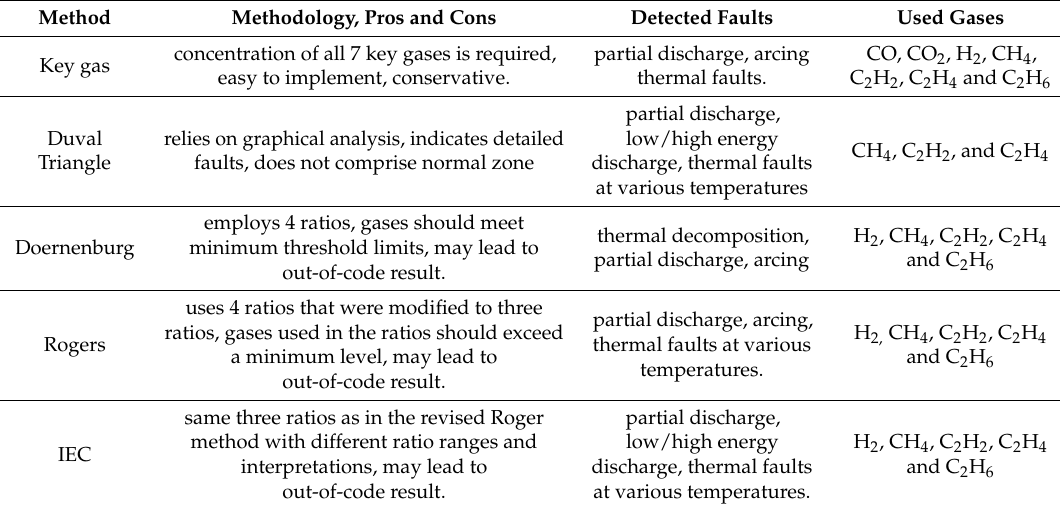
Table 1. A comparison of the five DGA interpretation